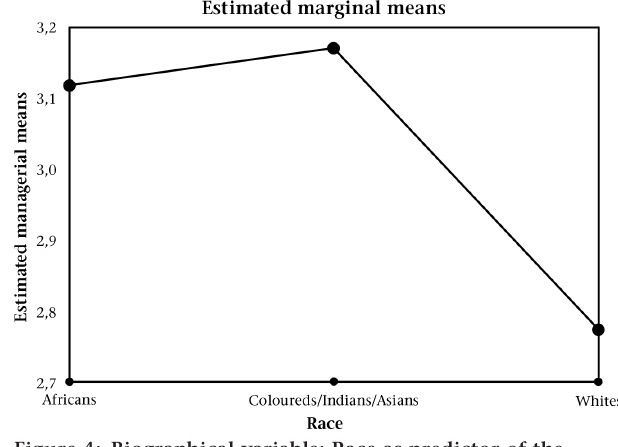
Figure 4: Biographical variable: Race as predictor of the perception of employment equity